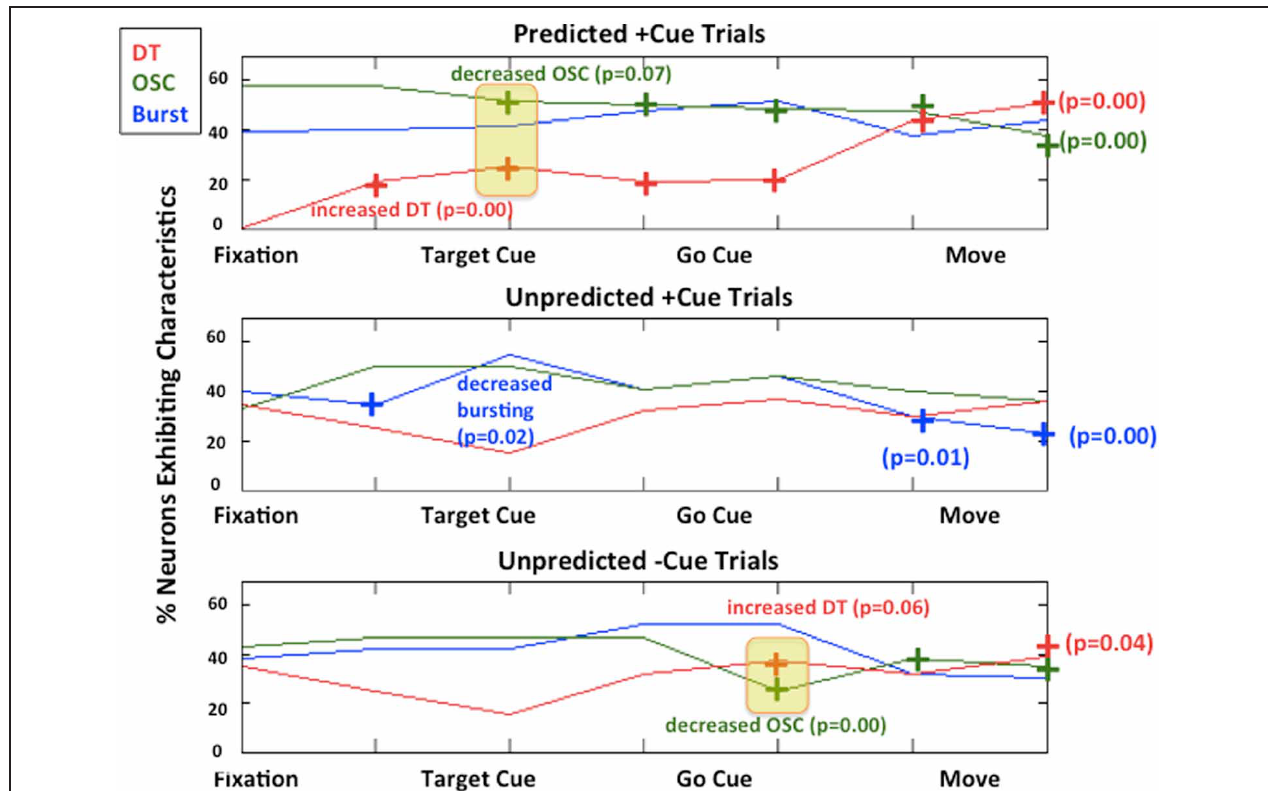
FIGURE 5 | Modulations of each characteristic for each trial type. Predicted + Cue Trials (top); Unpredicted + Cue Trials (middle); Unpredicted − Cue Trials (bottom). When the percentage of neurons exhibit